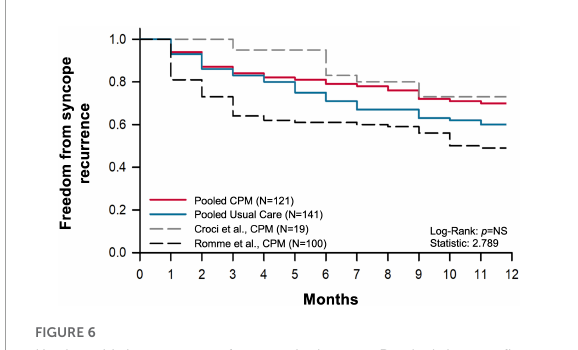
FIGURE6 Kaplan–Meier syncope-free survival curve. Pooled time to first syncopal recurrence over a 1-year follow up in groups provided with usual care and trained in counter pressure maneuvers (CPM), and controls (usual care only) were compared (9, 87). Each study followed patients with vasovagal syncope who experienced prodromal symptoms prior to syncope. Data reported by Croci et al. (86) and Romme et al. (93), (dashed) did not include a control group and therefore were not included in combined